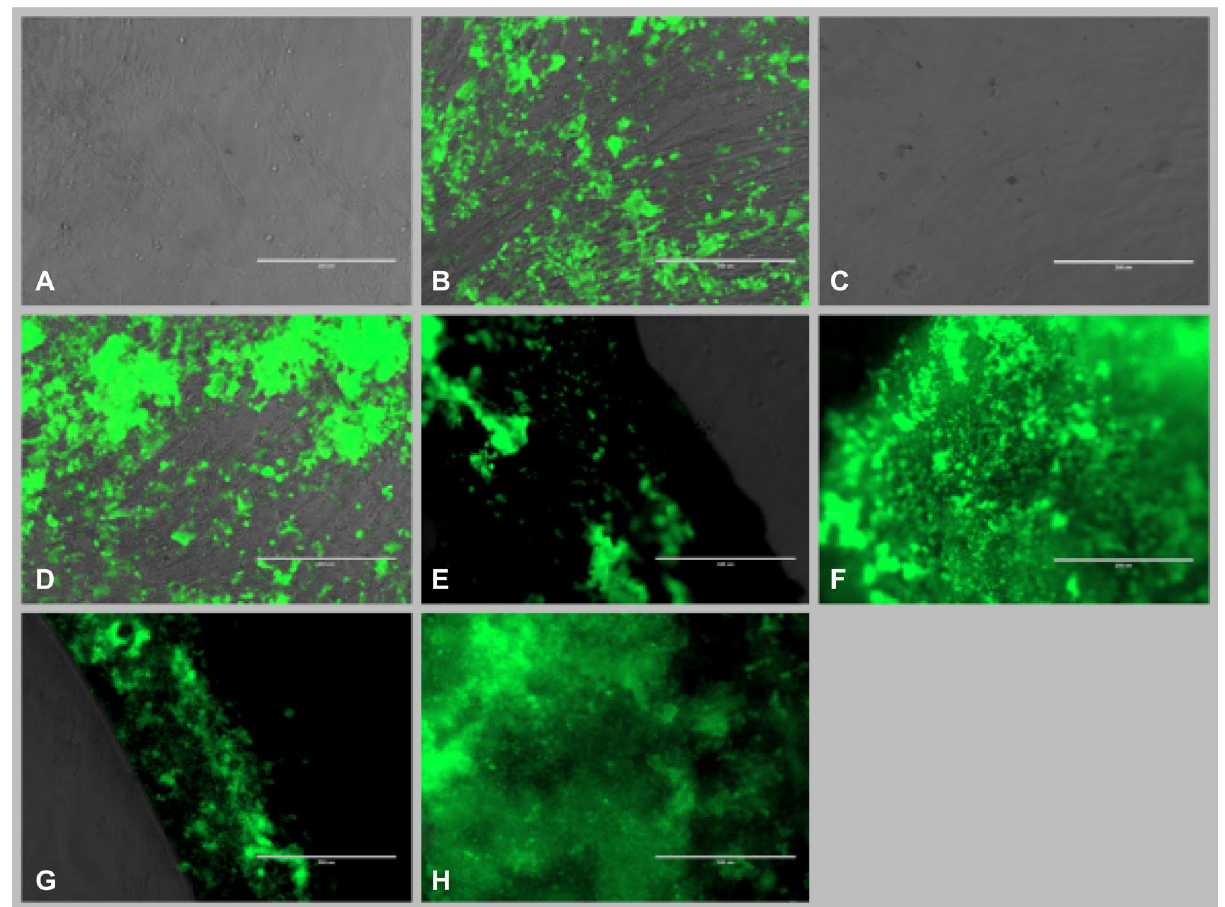
Figure 6. ASCs differentiation: ( A–H) fluorescence microscope images of osteogenic differentiation: ( A ) control (ASCs on regular culture plates in simple culture media); ( B ) ASCs in regular plates in osteogenic media; ( C ) control MF exposed ASCs in simple culture media; ( D ) ASCs in regular plates in osteogenic culture media; ( E ) ASCs on NW substrate in simple culture media; ( F ) ASCs on NW substrate in osteogenic media ( G ); ASCs on NW substrates exposed to MF in simple culture media; ( H ) ASCs on NW substrates exposed to MF in osteogenic media OsteoImage ® fluorescent staining of mineralized matrix deposition (extracellular), all images represent overlay of transmitted and GFP fluorescence images captured with inverted fluorescent microscope (Evos FL Life